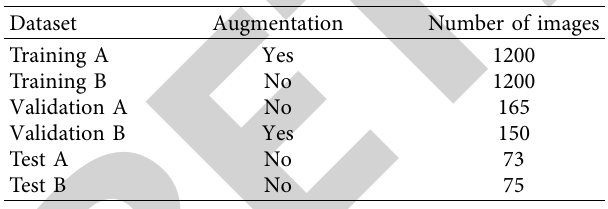
vertical horizontal Figure 3: Examples of data augmentation used for training. Table 2: Split data into training, validation, and testing for daytime (A) and nighttime (B).